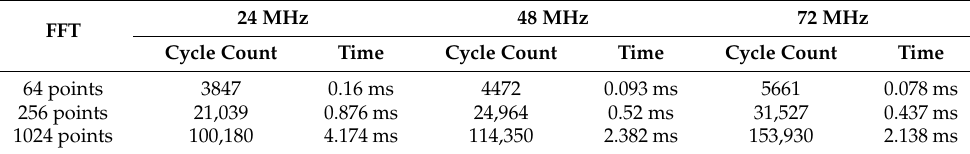
Table 4. FFT operation